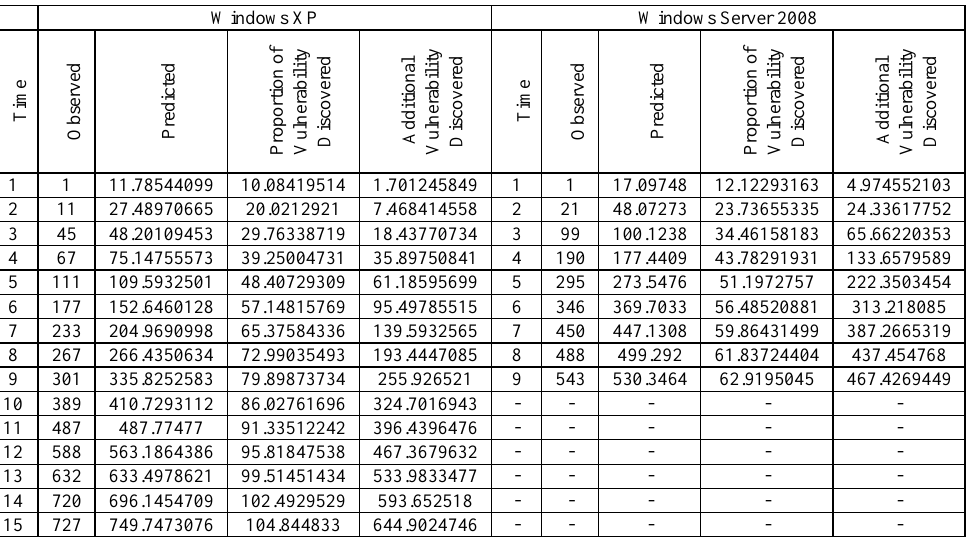
Table 3. Predicted and vulnerability proportions for Windows